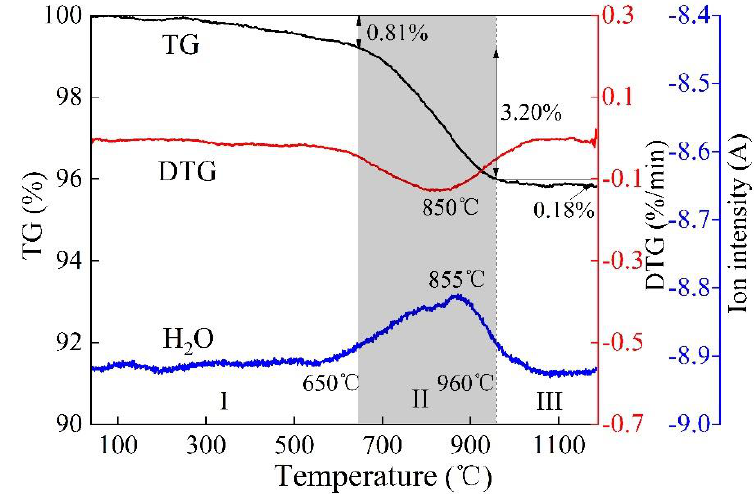
Figure 4. TG-MS analysis of raw sericite.